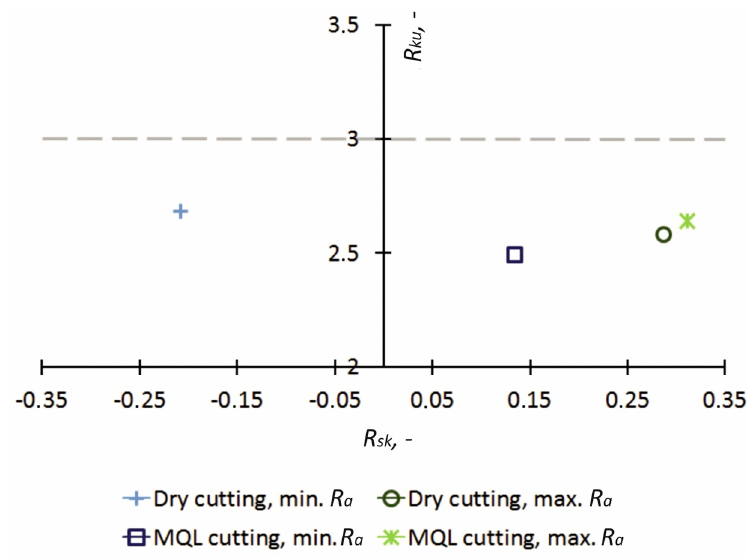
Figure 3. R ku –R sk topological map for Ti6Al4V alloy after finish turning.